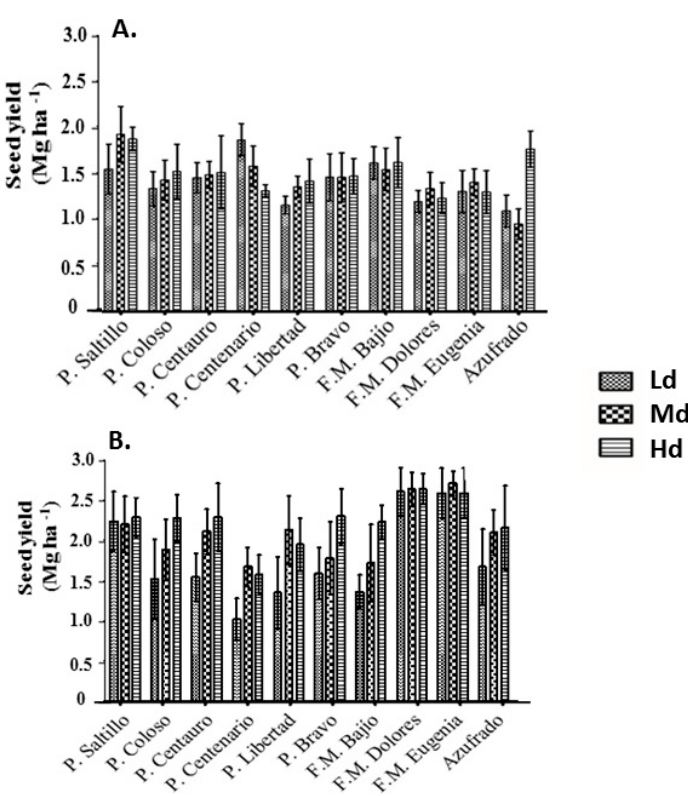
Figure 4. Yield of ten dry bean ( Phaseolus vulgaris L.) cultivars established at 90,000 plants ha − 1 (Low density, Ld), 145,000 plants ha − 1 (Medium density, Md) and 260,000 plants ha − 1 (High density, Hd) under rainfed conditions, with 175 mm ( A ) and 492 mm ( B ) of precipitation during the 2011 and 2013 growing seasons in Pabellon de Arteaga, Aguascalientes, Mexico. The standard error of the mean of five plots is indicated by the vertical bars.